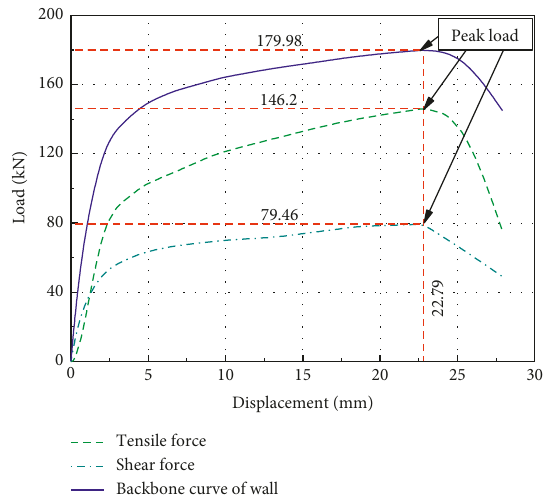
Figure 26: Internal force of the connection in MFEM-SW2.